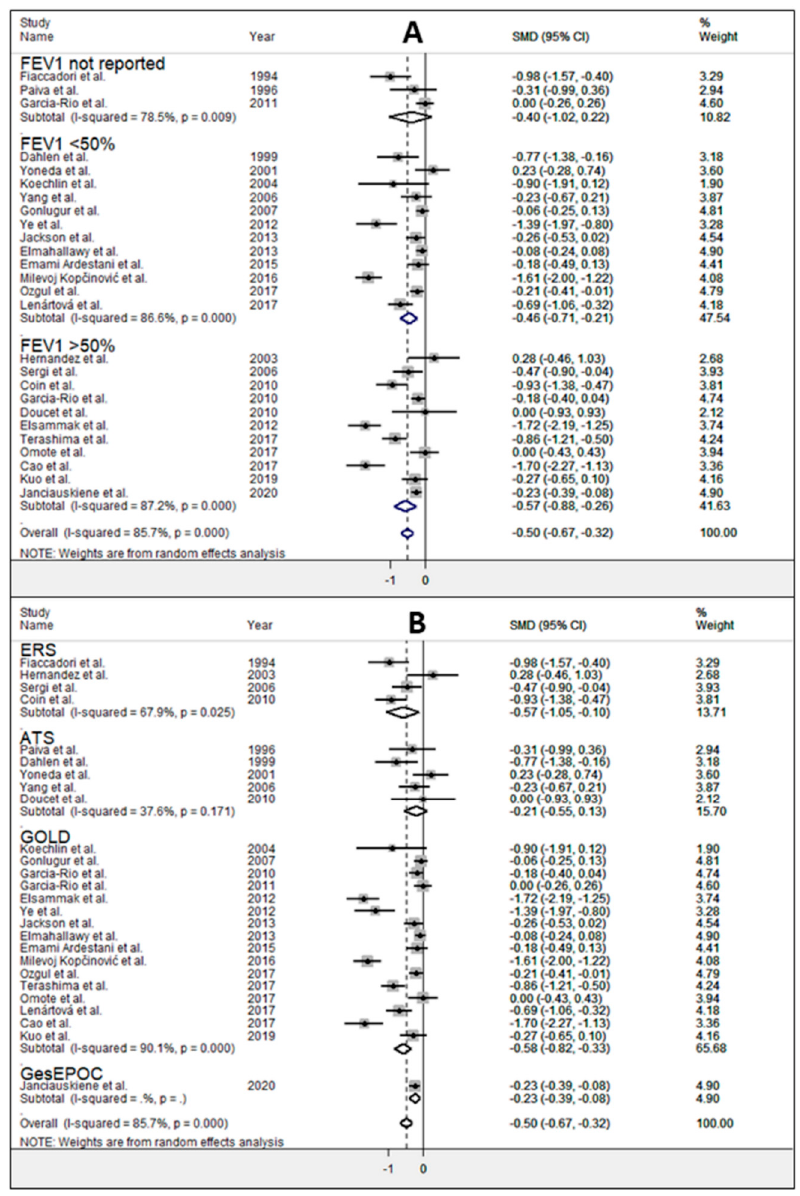
Figure 5. Forest plot of studies examining albumin and COPD according to disease severity evaluated by FEV 1 ( A ) and guidelines used for the diagnosis ( B ).